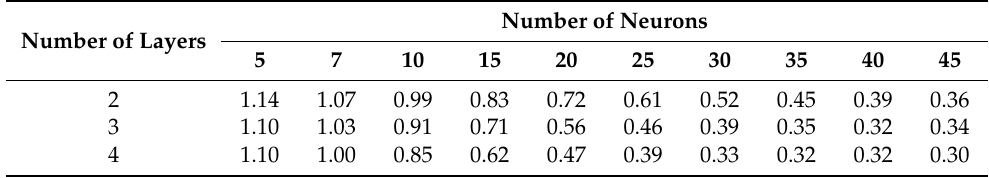
Table 7. Comparison of neural network structures, MAE error [m/s]. Number of